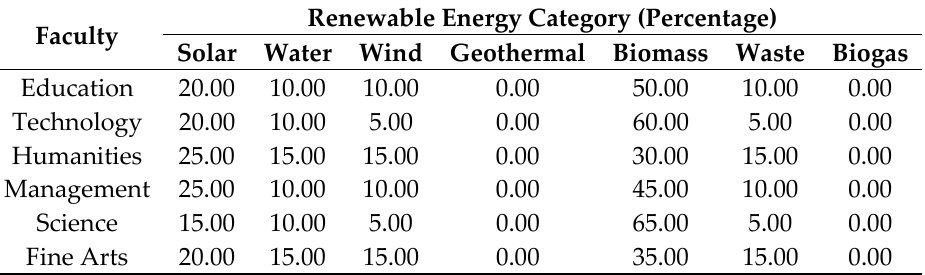
Table 1. Renewable Energy Used to Produce Energy.